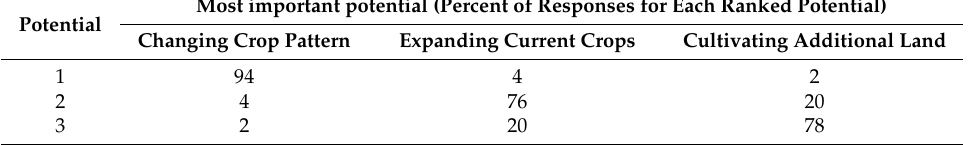
Table 5 summarizes the main statistics for the independent variables used in this study. The dependent variable had a mean of 0.85 (i.e., based on a value of one in 39 out of 46 observations) and a standard deviation of 0.36, with Max and Min at 1 and 0,